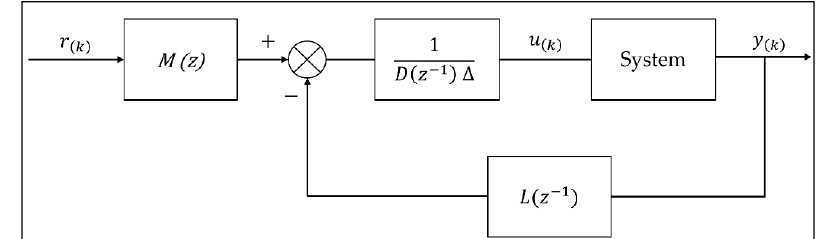
Figure1. System’scontrollerfeedbackblocsofthegeneralizedpredictivecontrol(GPC)-basedcontrolled Figure 1. System’s controller feedback blocs of the generalized predictive control (GPC)-based auto-regressive integrated moving average (CARIMA) controlled auto-regressive integrated moving average (CARIMA) model.